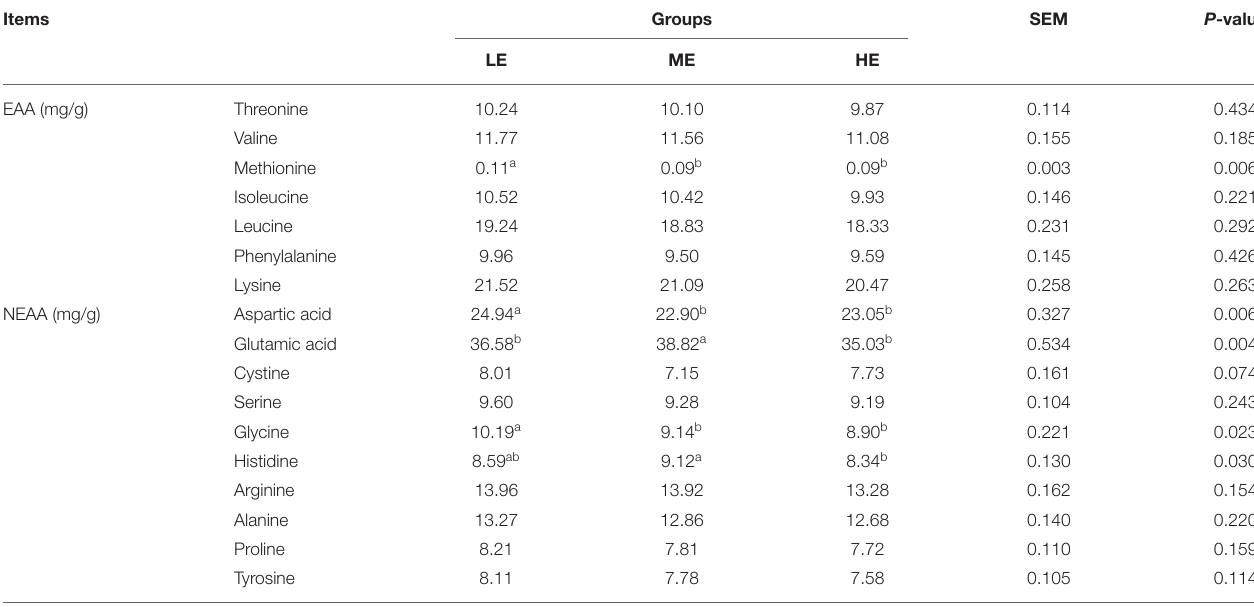
TABLE 3 | Effect of dietary energy levels on the amino acids content in the longissimus thoracis muscle of yak. Items Groups SEM P -value